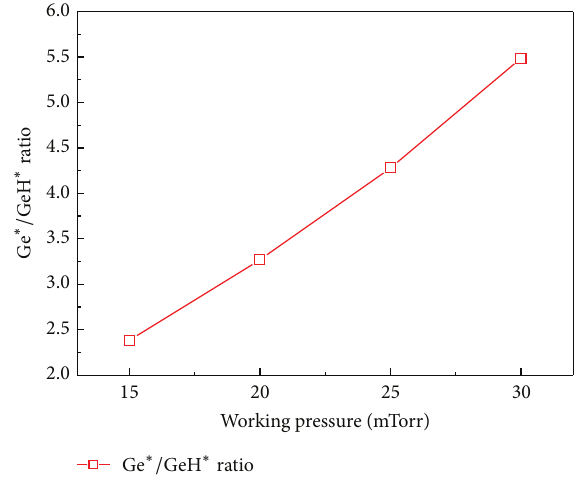
Figure 2: The OES Ge ∗ / GeH ∗ ratio as a function of working pressure.